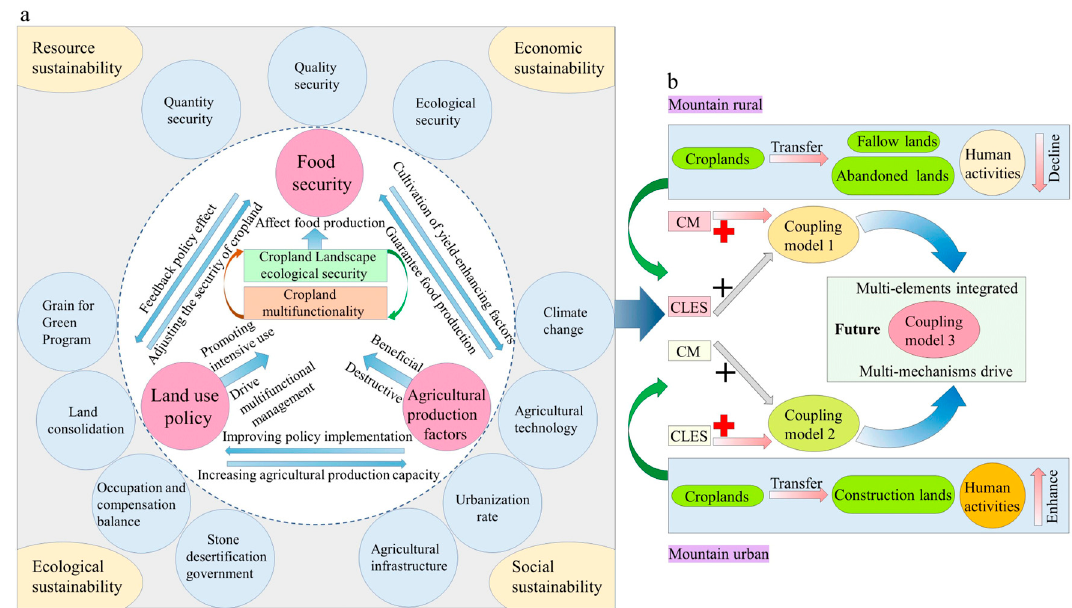
Figure 9. The advanced stage development model for the sustainable management of cropland: ( a ) driving mechanisms for CLES and CM coupled systems; ( b ) the future of coupled models of sustainable development of cropland; CLES: cropland landscape ecological security; CM: cropland multifunctionality.